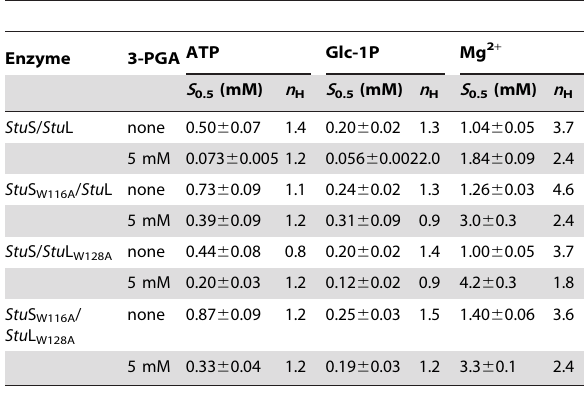
Table 2. Kinetic parameters for the substrates of wild type potato tuber ADP-Glc PPase and its Trp mutants.